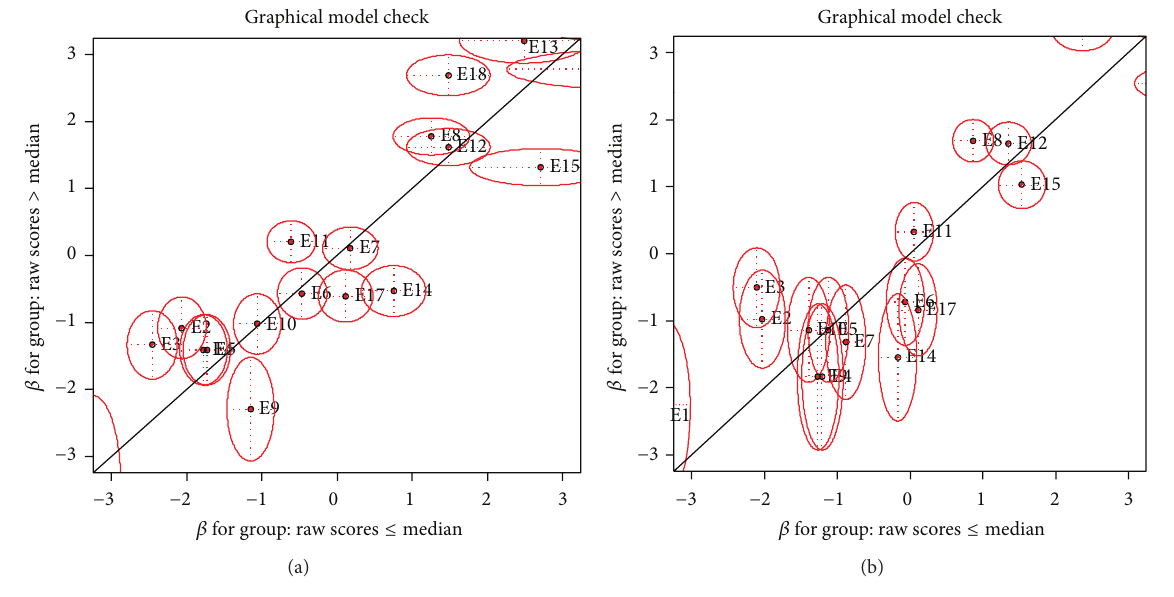
Figure 2: Graphical Rasch model check for Tororo (a) and Busia (b) districts.